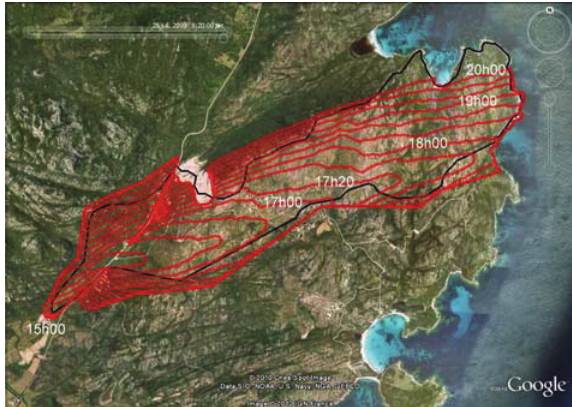
Figure 10: Simulated intermediate fire perimeters obtained with a constant wind (25km h − 1 , 290 ◦ ) and observed final perimeter in black for Suartone fire.